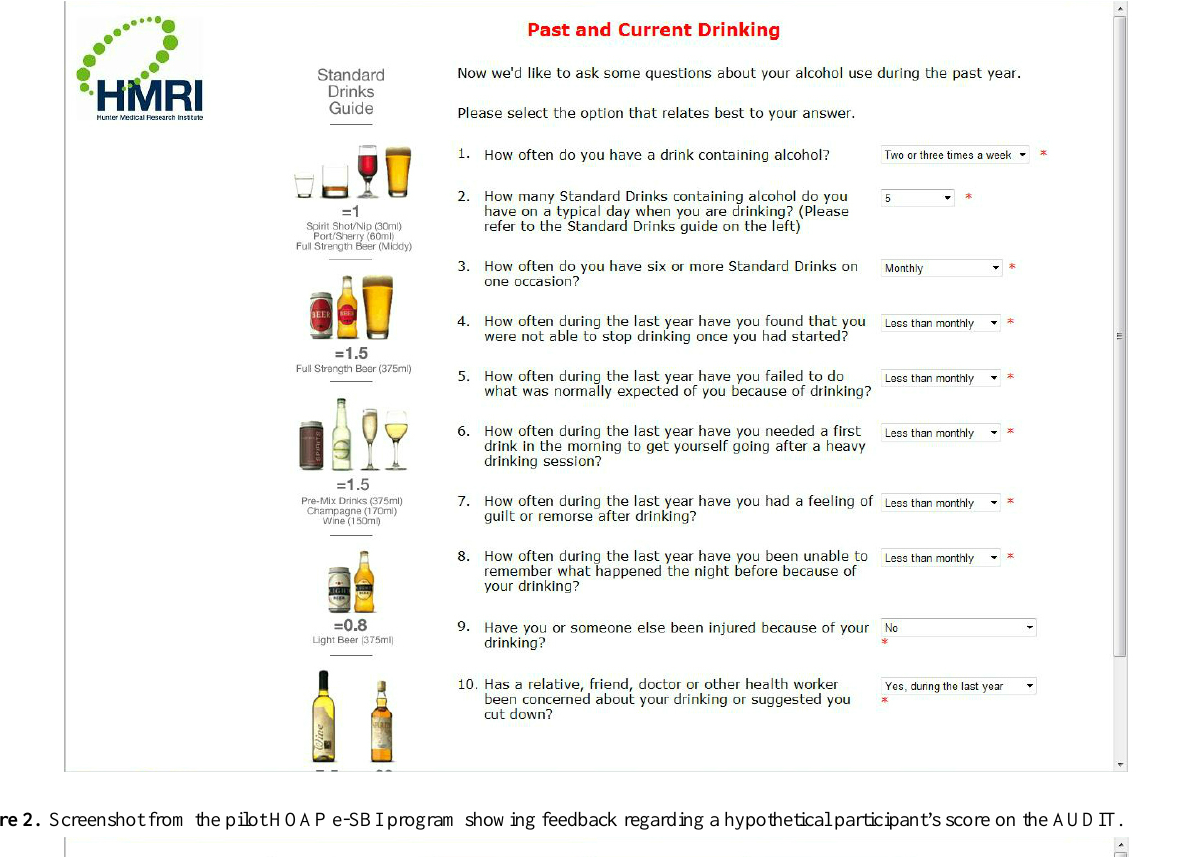
Figure 1. Screenshot from the pilot HOAP e-SBI program showing the AUDIT.